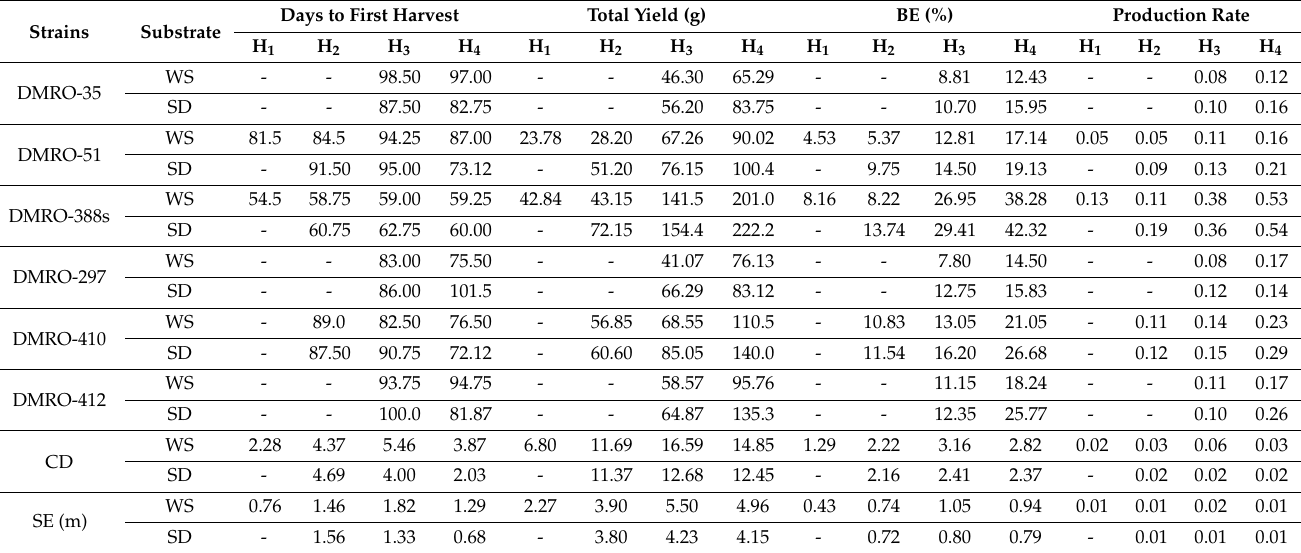
Table 1. Productivity of shiitake strains on wheat straw (WS) and sawdust (SD) at different substrate heat treatment